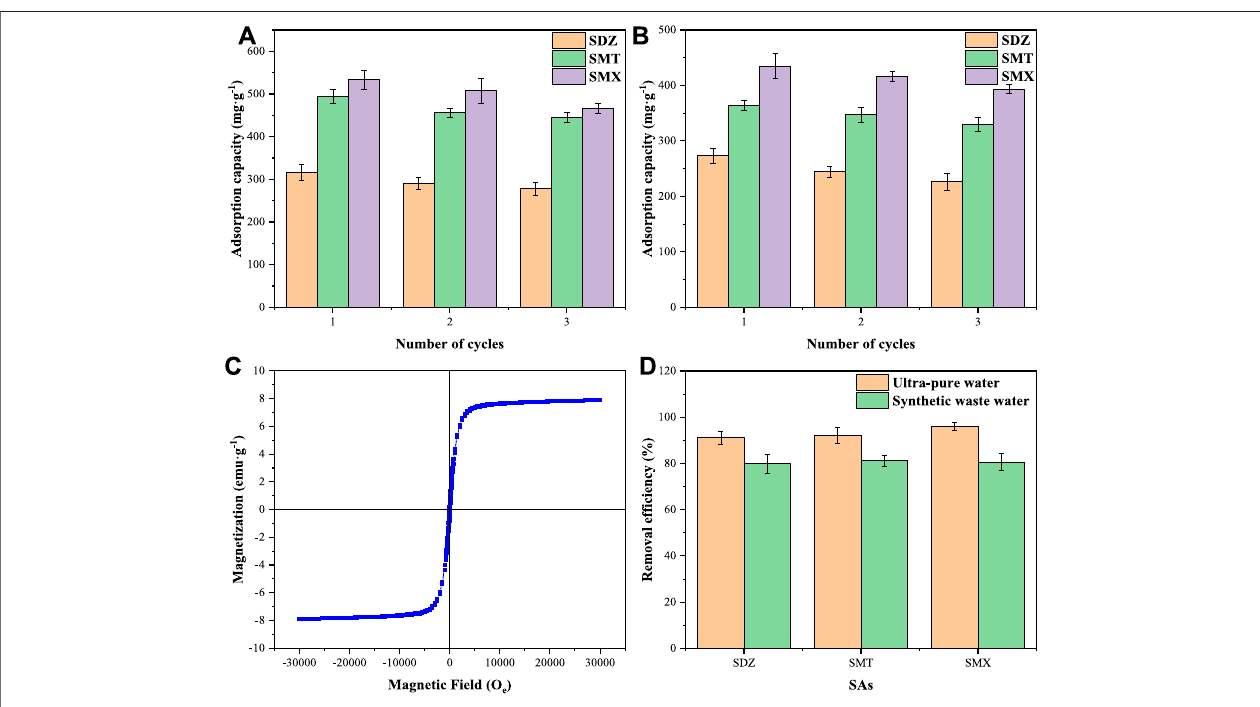
FIGURE 6 | The reusability tests for BC-KOH 2.5 (A) and 50MBC-KOH 2.5 (B) . (C) The magnetization curve of 50MBC-KOH 2.5 after three cycles. (D) Ef fi ciencies of SA (50 mg L − 1 ) removal by adsorption on 50MBC-KOH 2.5 from ultra-pure water and synthetic wastewater in 24 h at pH 5.0.